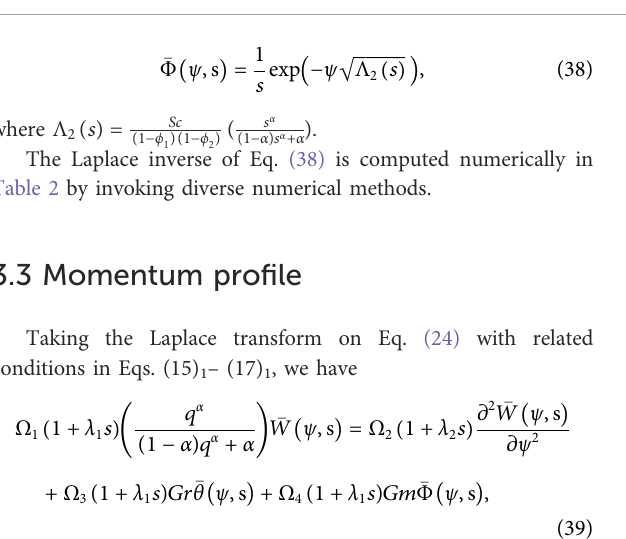
FIGURE 3 Simulation to explain the temperature for Pr when α (cid:3) 0 .